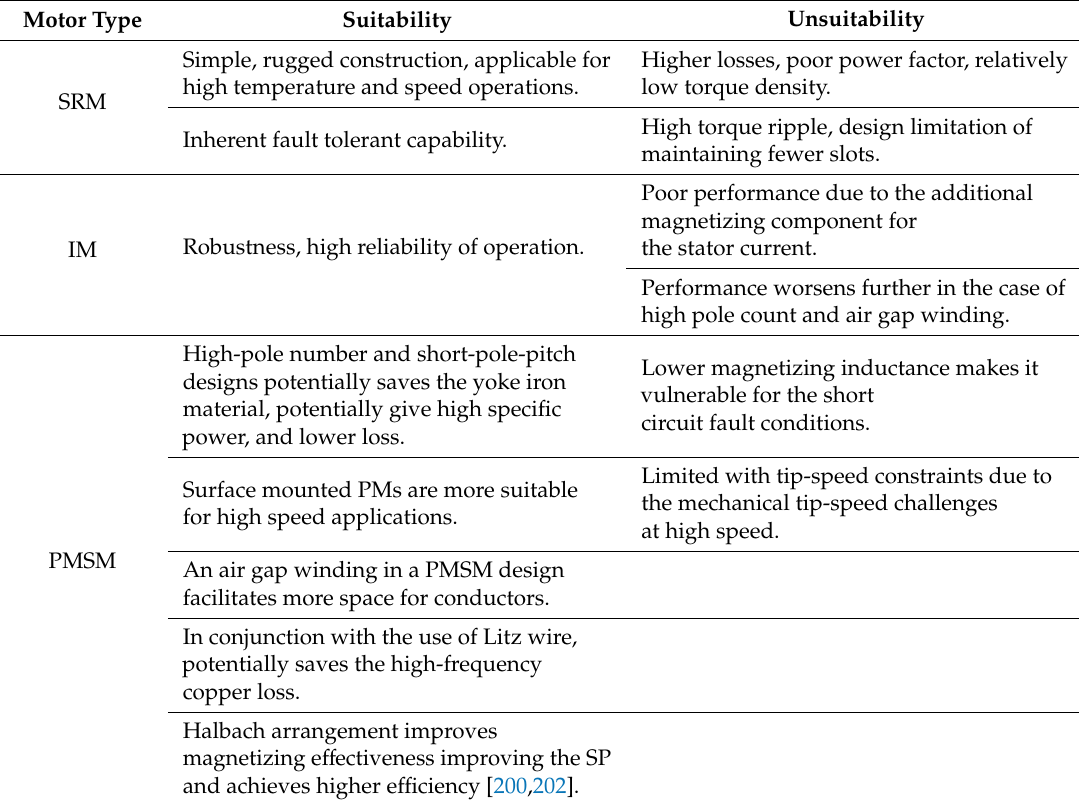
Table 4. Summary of electrical machines for aircraft